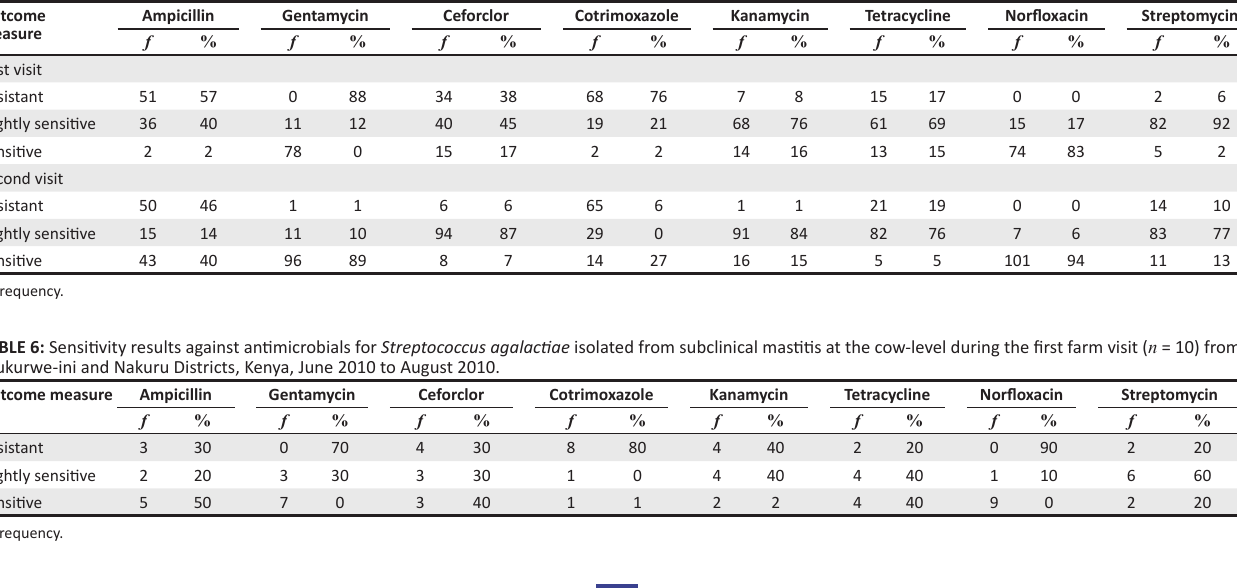
TABLE 5: Sensitivity results against antimicrobials for Staphylococcus aureus isolated from subclinical mastitis at the cow-level during the first ( n = 89) and second ( n = 108) farm visits in Mukurwe-ini and Nakuru Districts, Kenya, June 2010 to August 2010. Outcome measure